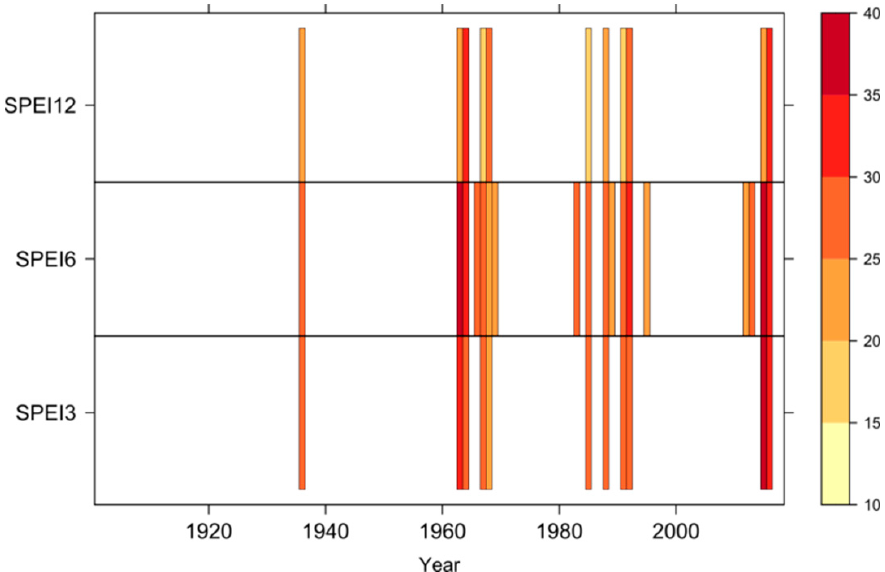
Figure 5. Drought spatial coverage of the extreme drought events based on the SPEI3, SPEI6, and SPEI12 time series in the ARB during 1901–2018. The calculation of the drought spatial coverage is based on the number of pixels with values of SPEI ≤ − 1.00, regardless of the time scale used. To investigate the impacts of the extreme drought events in terms of intensity and temporal persistence, each extreme drought event listed in Table 2 was isolated. Then, the intensity and the temporal persistence were calculated for each pixel using the methods described earlier. Figure 6 displays the spatial distribution of the intensity and the temporal persistence over the ARB during the incidence of the SPEI3, SPEI6, and SPEI12 extreme drought events. A visual inspection of this figure reveals that the SPEI3-based E4 event showed a relatively large area with the highest values of intensity (intensity values >3) on the low part of the Ucayali and Napo River sub-basins near the Peru–Brazil border (see Figure 6a). In contrast, the other drought events were characterized by the presence of large areas with low to moderate intensity (intensity values ≤ 3). A high temporal persistence of drought conditions was observed on large geographical regions for all drought events regardless of the local intensity (see Figure